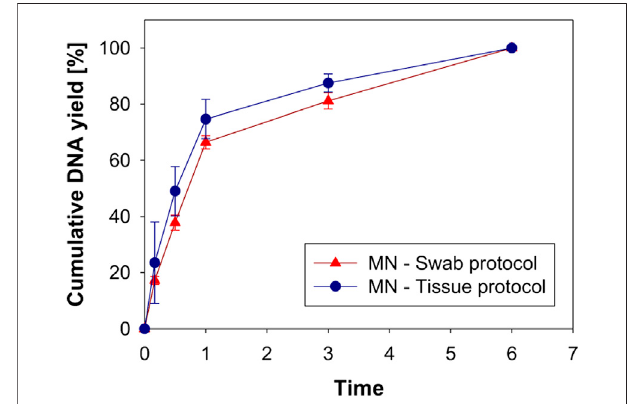
FIGURE 8 | DNA yield according to lysis time and extraction